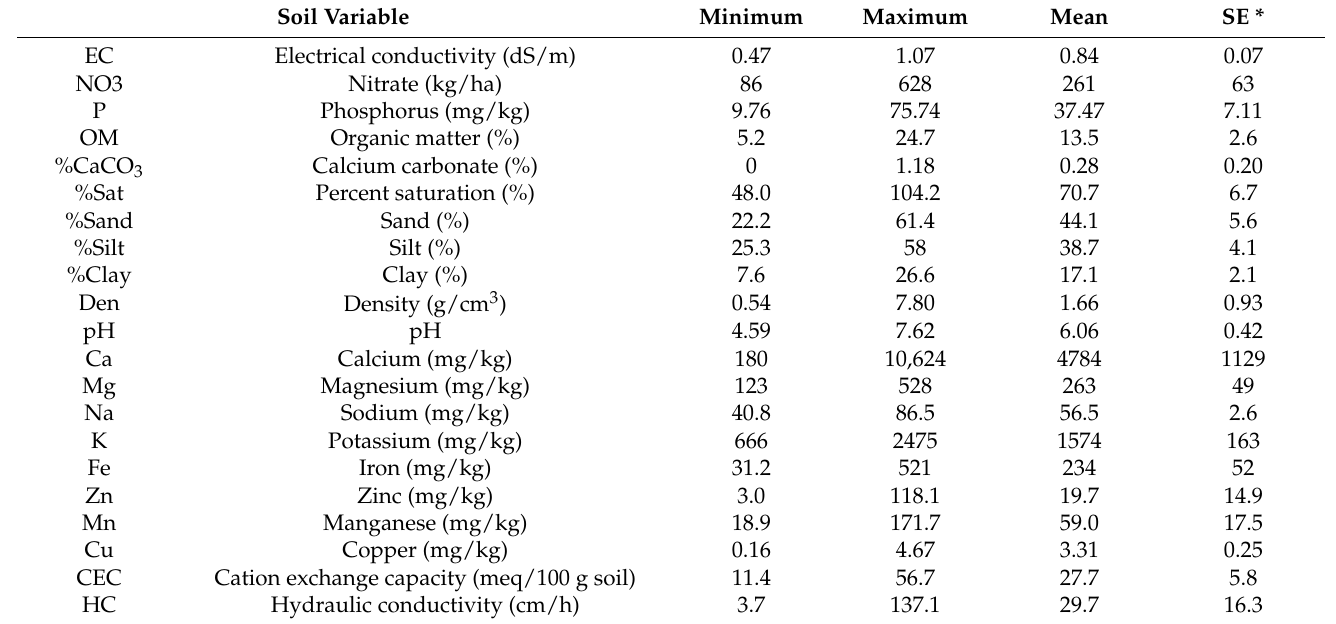
Table 3. Descriptive statistics for the 27 soil variables in provenance of P. martinezii and P. mexicana used for the environment–phenotype associations tests (* SE = standard error (sample = 56); data of Picea chihuahuana from [20] are not inserted in the